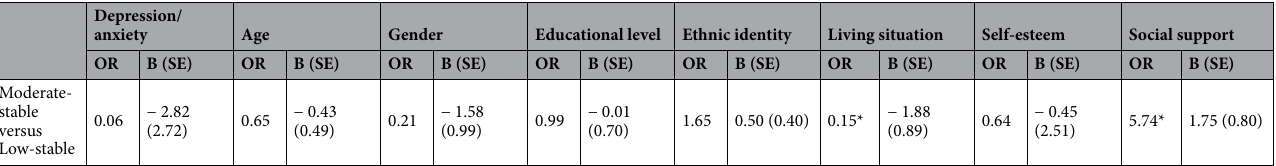
Table 7. Results of the multinomial logistic regression analyses for the latent classes of depression and anxiety (N = 177). OR odds ratio. *** p < .001; ** p < .01; * p <